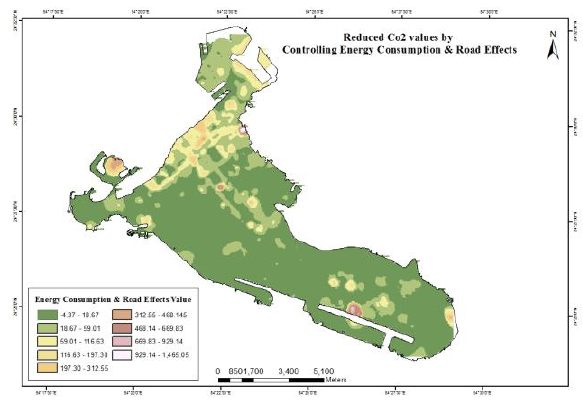
Figure 10 Reduced CO2 (energy reduction and Road factors)